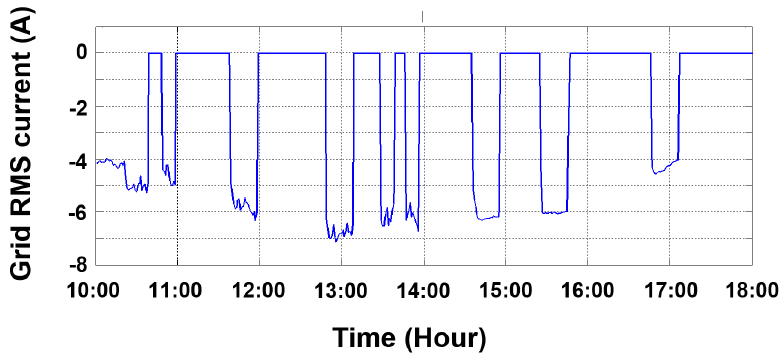
Figure 11. Rule-based EMS: grid RMS current.